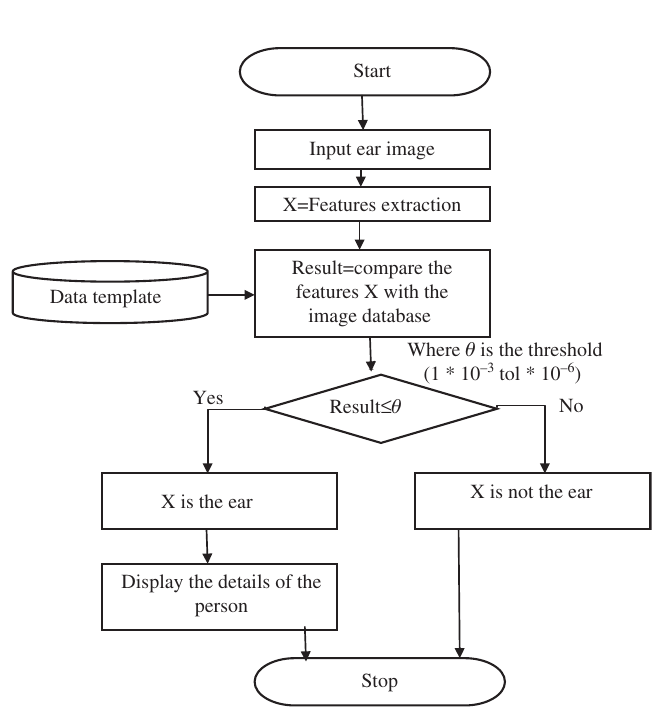
Figure 10: Functioning of Ear Recognition